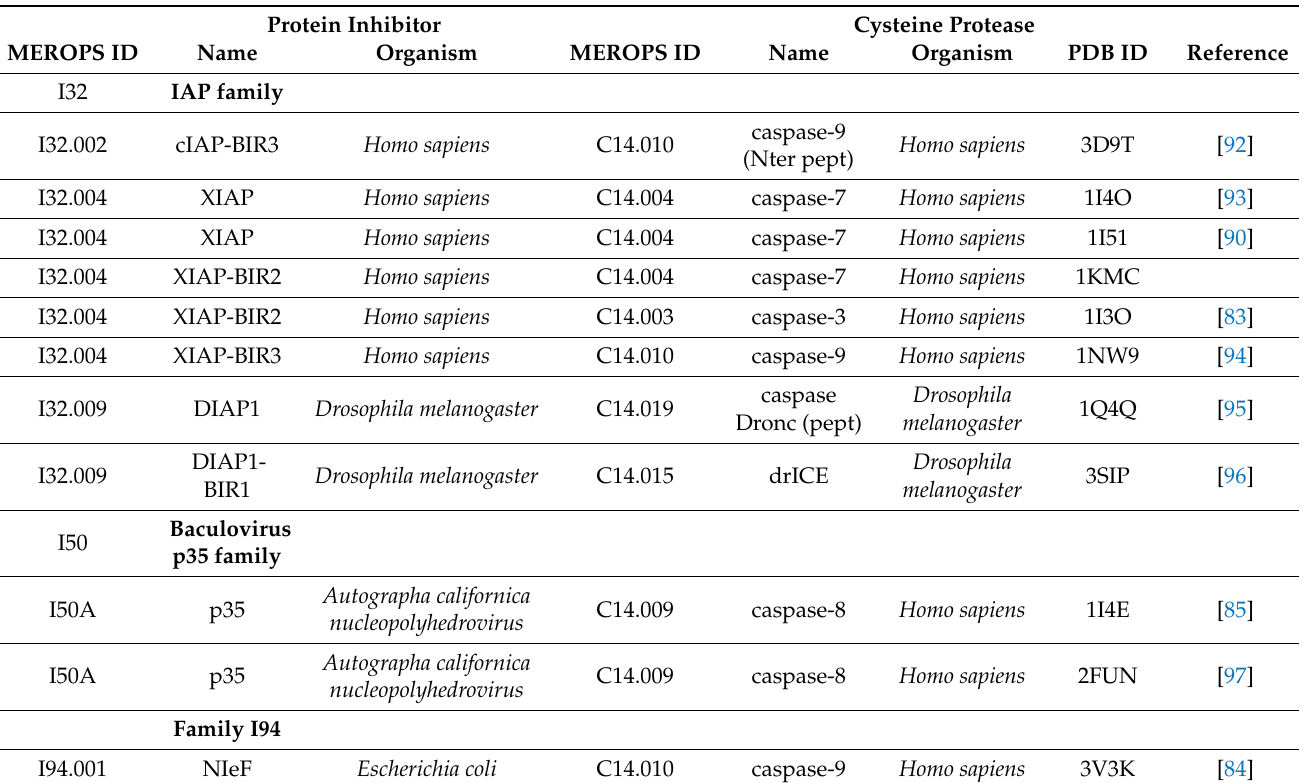
Table 3. List of the available structures of the complexes between protein inhibitors and cysteine proteases: IAPs, p35, and